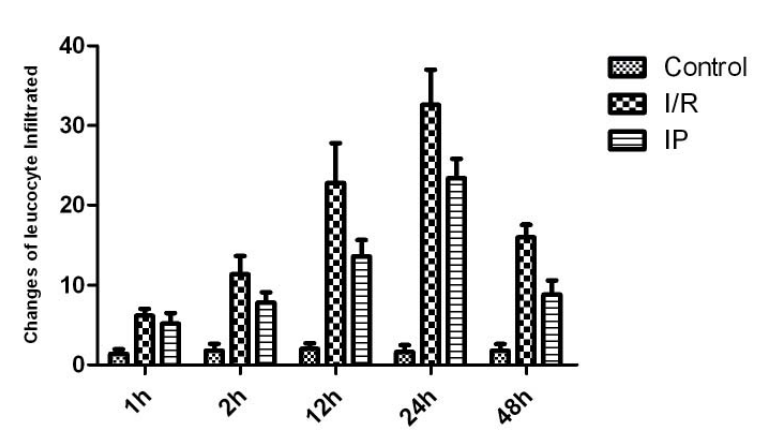
Figure 8 - Changes of leucocyte Infi ltrated into renal parenchyma after ischemic